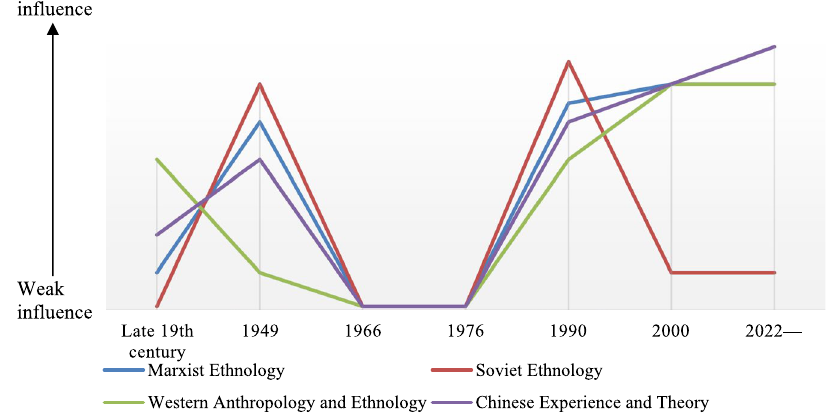
Fig. 2 Diagram of the forces influencing anthropological and ethnological research in China in different